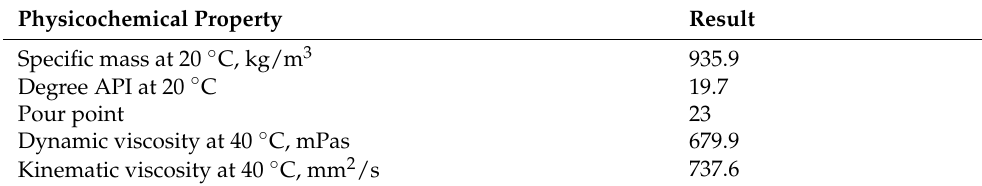
Table 2. Results of the physicochemical characterization of the ATR.